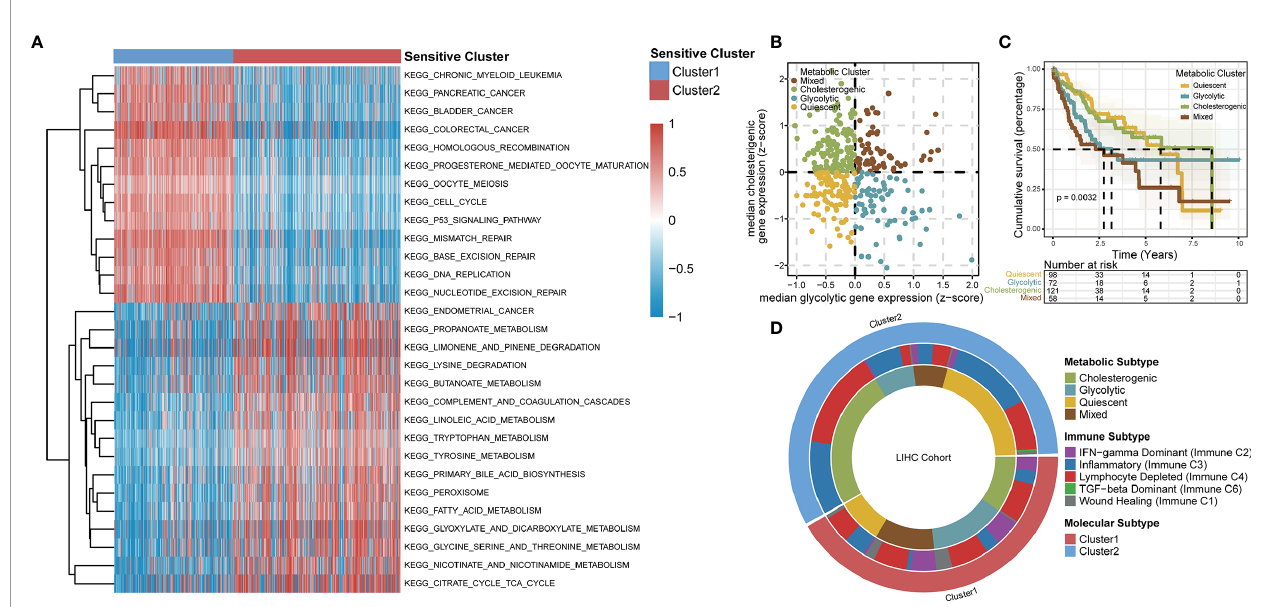
FIGURE 4 | TTK patterns vary with respect to the metabolic microenvironment. (A) GSVA enrichment analysis disclosing biological pathway differences between TTK patterns. The heatmap was generated to visualize these biological processes; red represents activated pathways and blue represents inhibited pathways. (B) Scatter plot showing median expression levels of co-expressed glycolytic ( x -axis) and cholesterogenic ( y -axis) genes in each HCC sample. Metabolic subgroups were assigned on the basis of the relative expression levels of glycolytic and cholesterogenic genes. (C) Kaplan – Meier survival analysis of patients with HCC strati fi ed by four metabolic subtypes clustered by glycolytic and cholesterogenic genes. (D) Circle diagram shows HCC subtypes for each sample and investigated their degree of overlap with TTK patterns, immune subtypes and metabolic